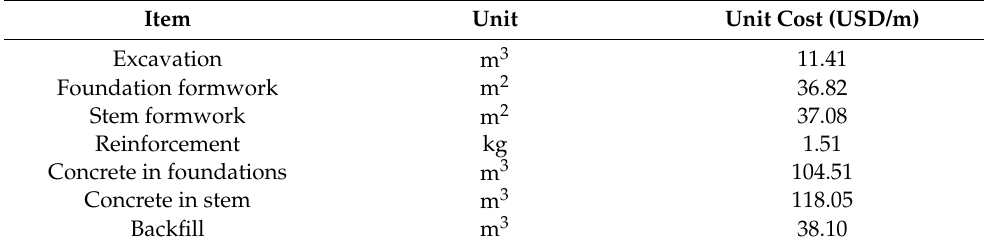
Table 10. Basic prices considered in the